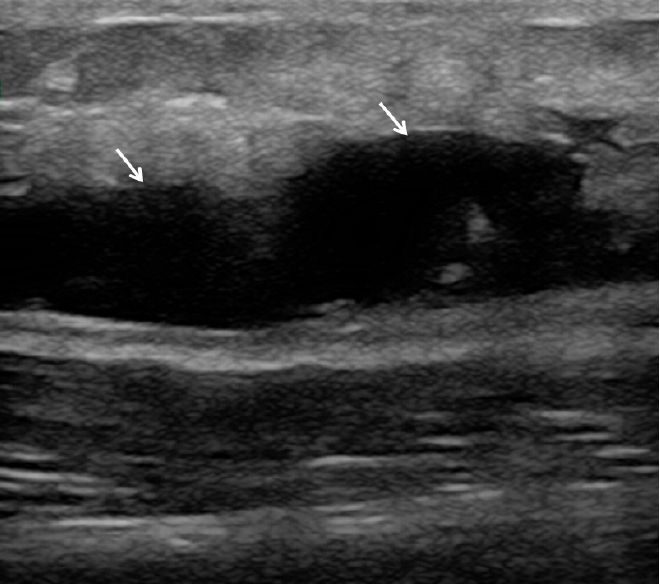
Figure 3. Liquefied hematoma (arrows, anechoic fluid collection).